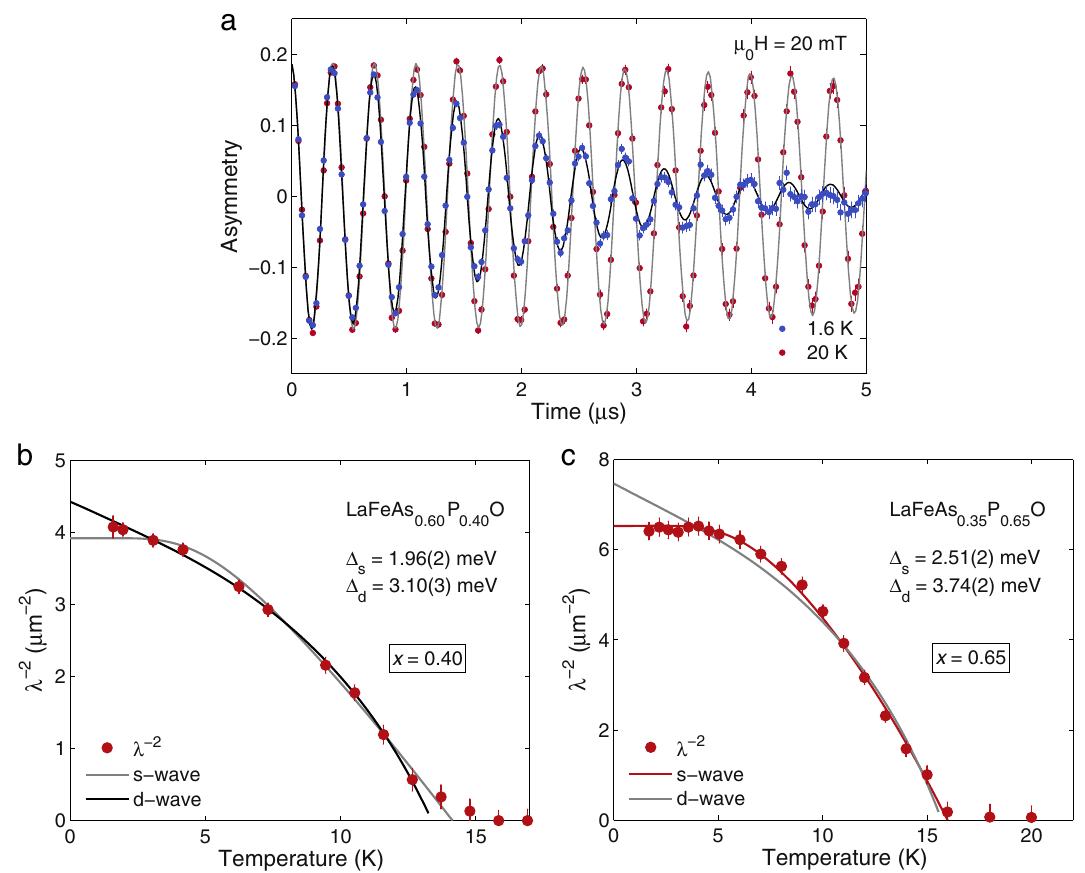
Fig. 3 Changing nature of SC from TF- μ SR data. a Representative LaFeAs 1 − x P x O μ SR spectra for x = 0.7, taken above and below T c in a 20-mT transverse fi eld. The onset of superconductivity upon lowering the temperature is re fl ected in a faster decay of the asymmetry. Temperature dependence of λ − 2 for x = 0.4 ( b ) and x = 0.65 ( c ) measured at μ 0 H = 20 mT. Solid lines indicate fi ts by means of s -wave and d -wave SC pairings. Notice the change in pairing character across x = 0.5. See text for